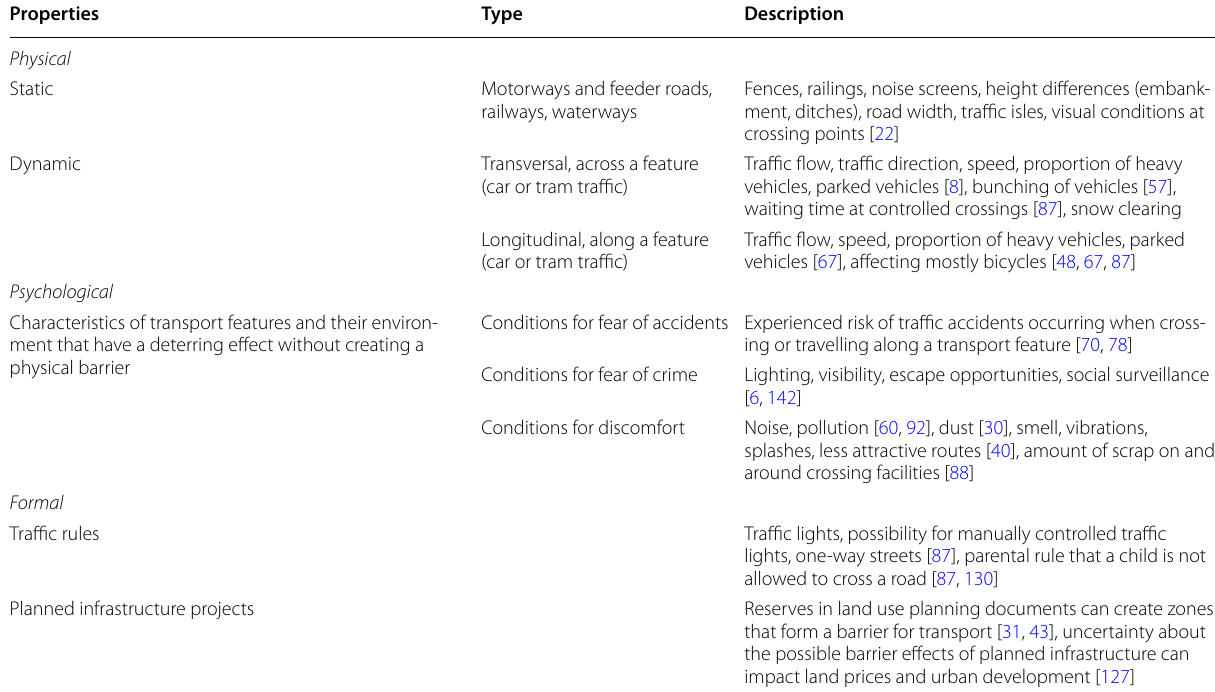
Table 1 Properties of transport features that determine barrier effects Properties